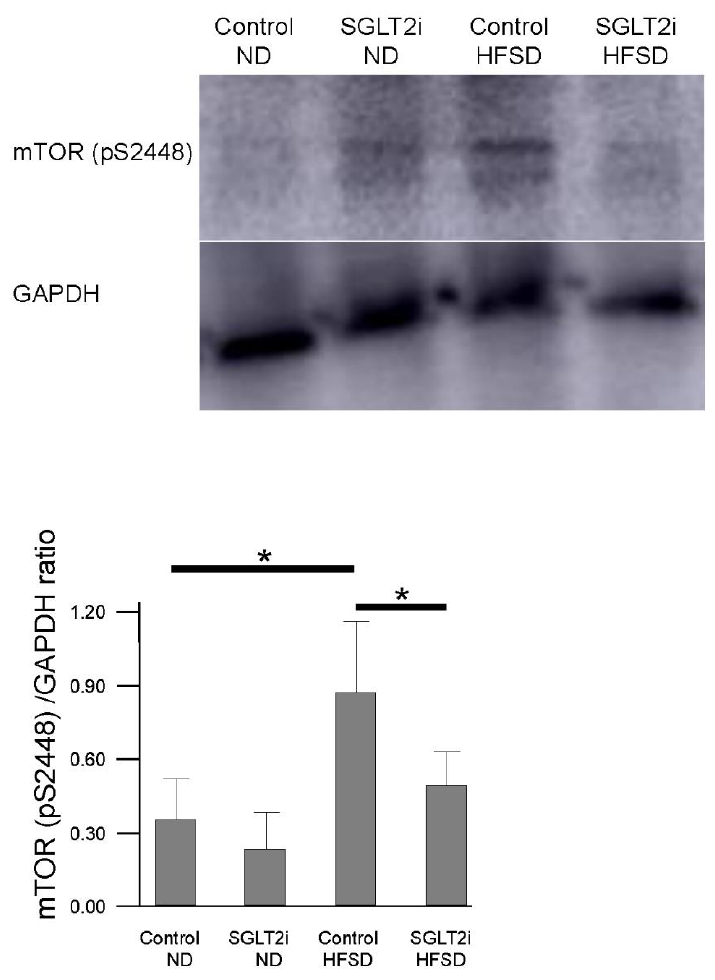
Figure 7. SGLT2 inhibitor (SGLT2i) suppressed mammalian target of rapamycin (mTOR) activation in renal proximal tubular cells of obesity mice. Western blotting analysis for mTOR phosphorylated on serine 2448 (mTOR (pS2448) of the kidney. Results are presented as the mean ± standard deviation. Differences were evaluated by two-way ANOVA followed by Tukey–Kramer test (* p < 0.05). SGLT2i: empagliflozin.